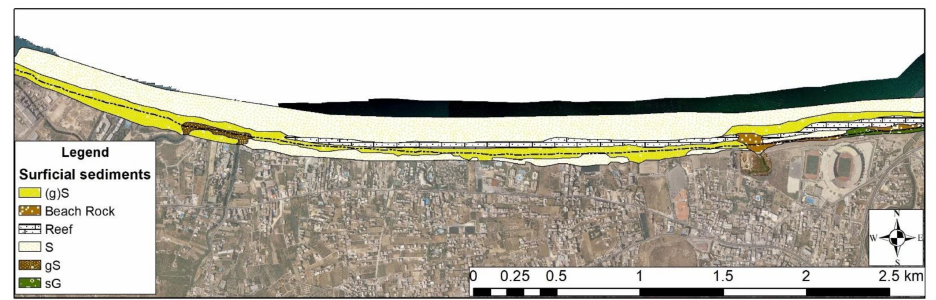
Figure 4. Textural characteristics (sand (S), slightly gravely sand ((g)S), gravely sand (gS), sandy